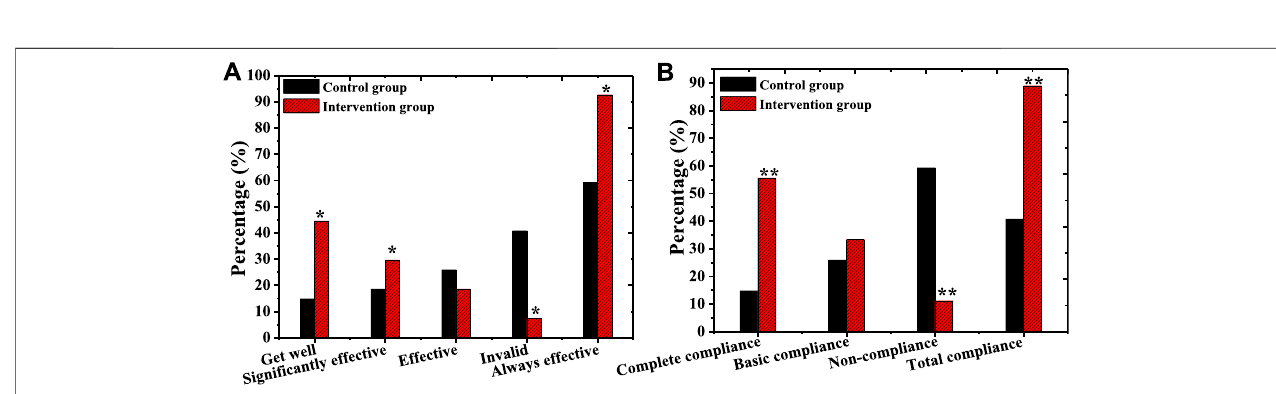
FIGURE 15 | Comparison on the ef fi cacy and compliance of depression after psychological intervention between the two groups.[Note: (A) : Comparison on the ef fi cacyofdepressionafterintervention betweenthetwogroupsofpatients; (B) :Comparison ofinterventioncompliancebetweenthetwogroupsofpatients;*indicated p < 0.05 compared with the control group; ** meant p < 0.01 compared with the control group].